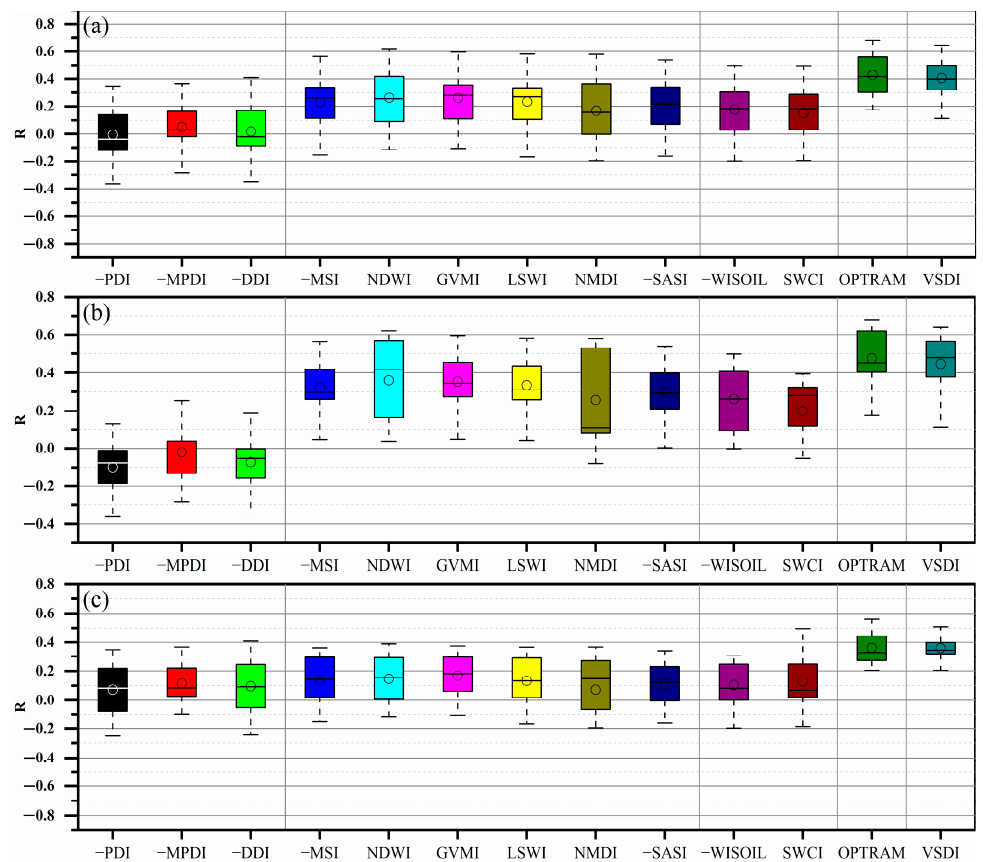
Figure 4. Box plots of Pearson’s R between the aircraft SM and the optical SM indexes during the whole study period in ( a ) all experiments, ( b ) the SMAPVEX12 experiment, ( c ) the SMAPVEX16 Manitoba experiment.